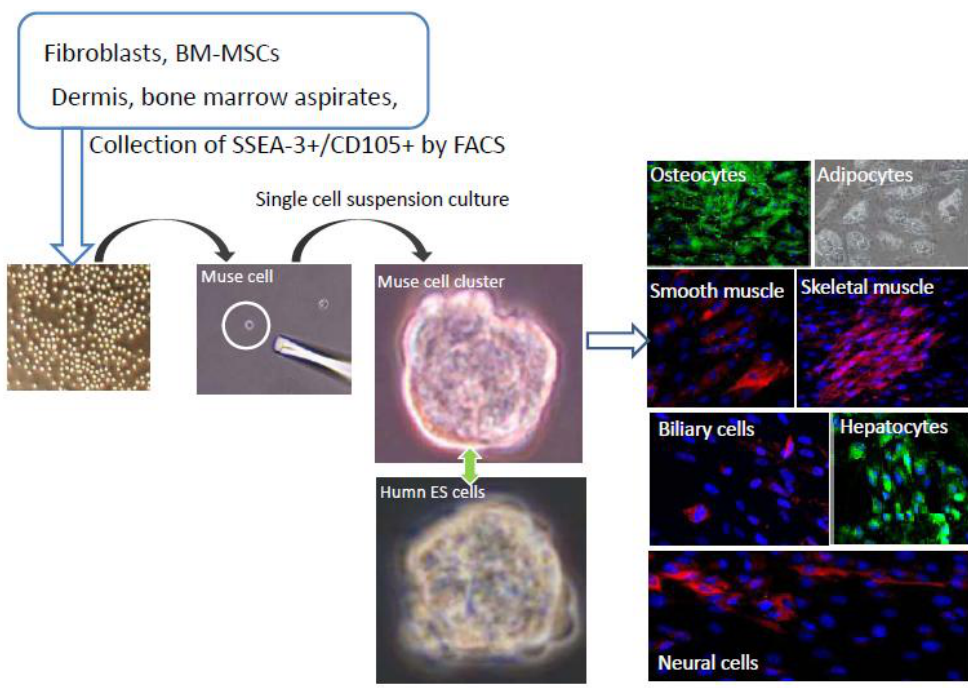
Figure 1. Isolation and characterization of Muse